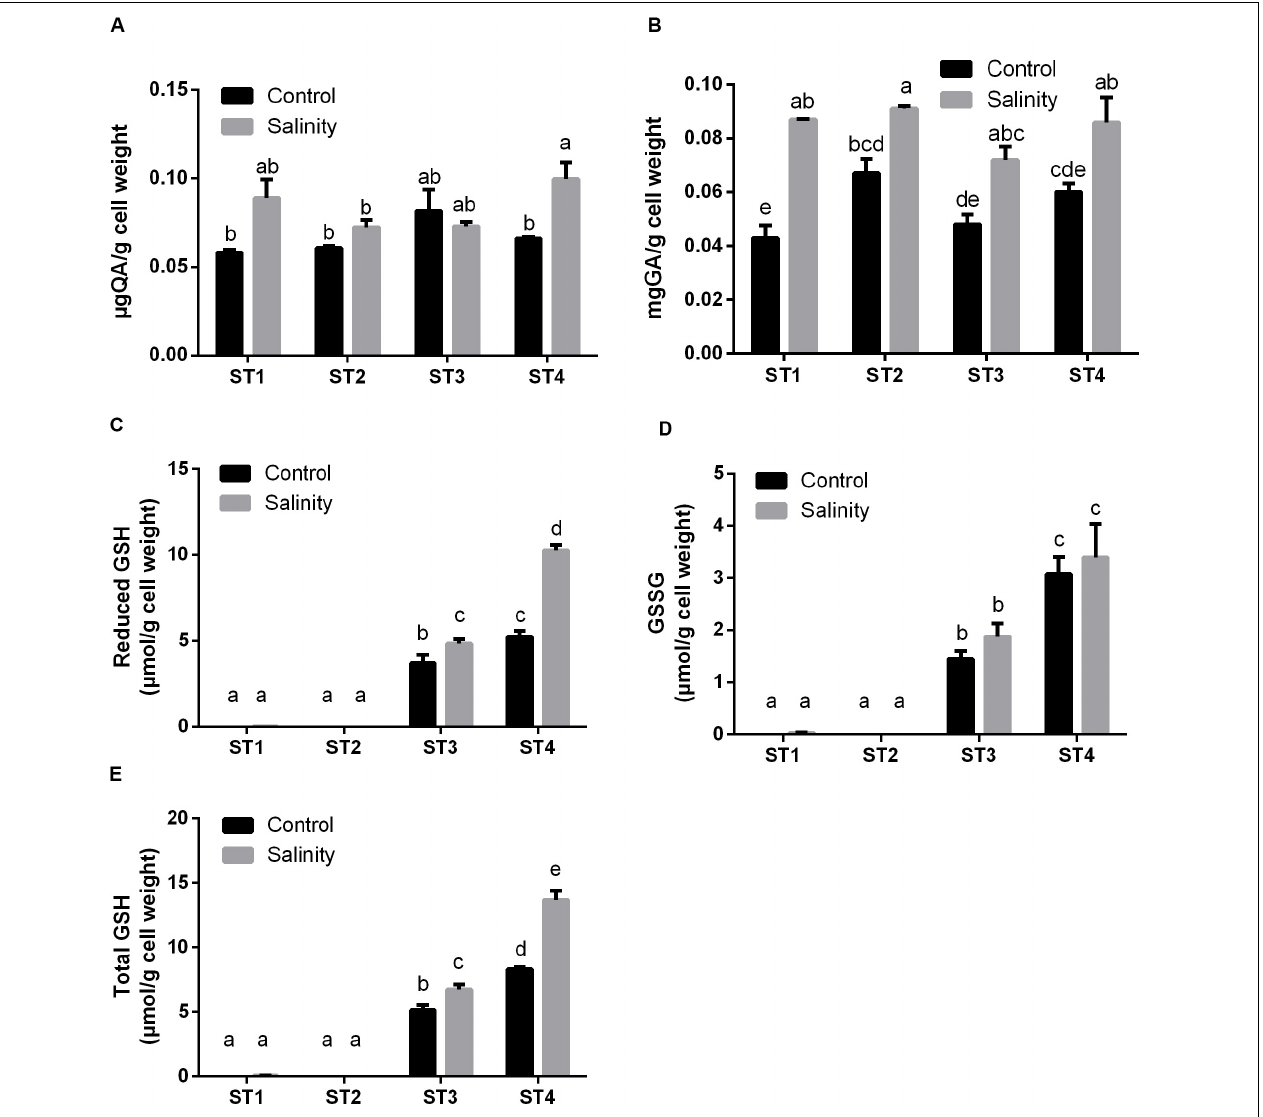
FIGURE 5 | The antioxidant metabolites of four salt-tolerant bacterial isolates (ST1, ST2, ST3, and ST4) in terms of (A) flavonoids, (B) polyphenols, (C) reduced GSH, (D) oxidized GSH (GSSG), and (E) total GSH per gram of bacterial cell weight under control and salinity stress conditions. Data are represented by the mean of at least three replicates, and error bars represent the standard error. Different small letters (a, b, c ... ) above bars indicate significant differences between means at p <